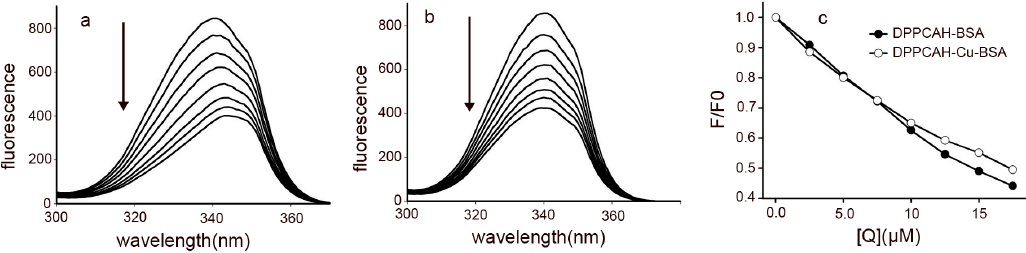
Figure 7. Effect of the addition of ( a ) DPPCAH and ( b ) DPPCAH-Cu on the synchronous fluorescence spectrum of BSA ( Δλ = 60 nm); ( c ) changes in fluorescence quenched by agents: C BSA = 10.0 μ M, at 288 K.